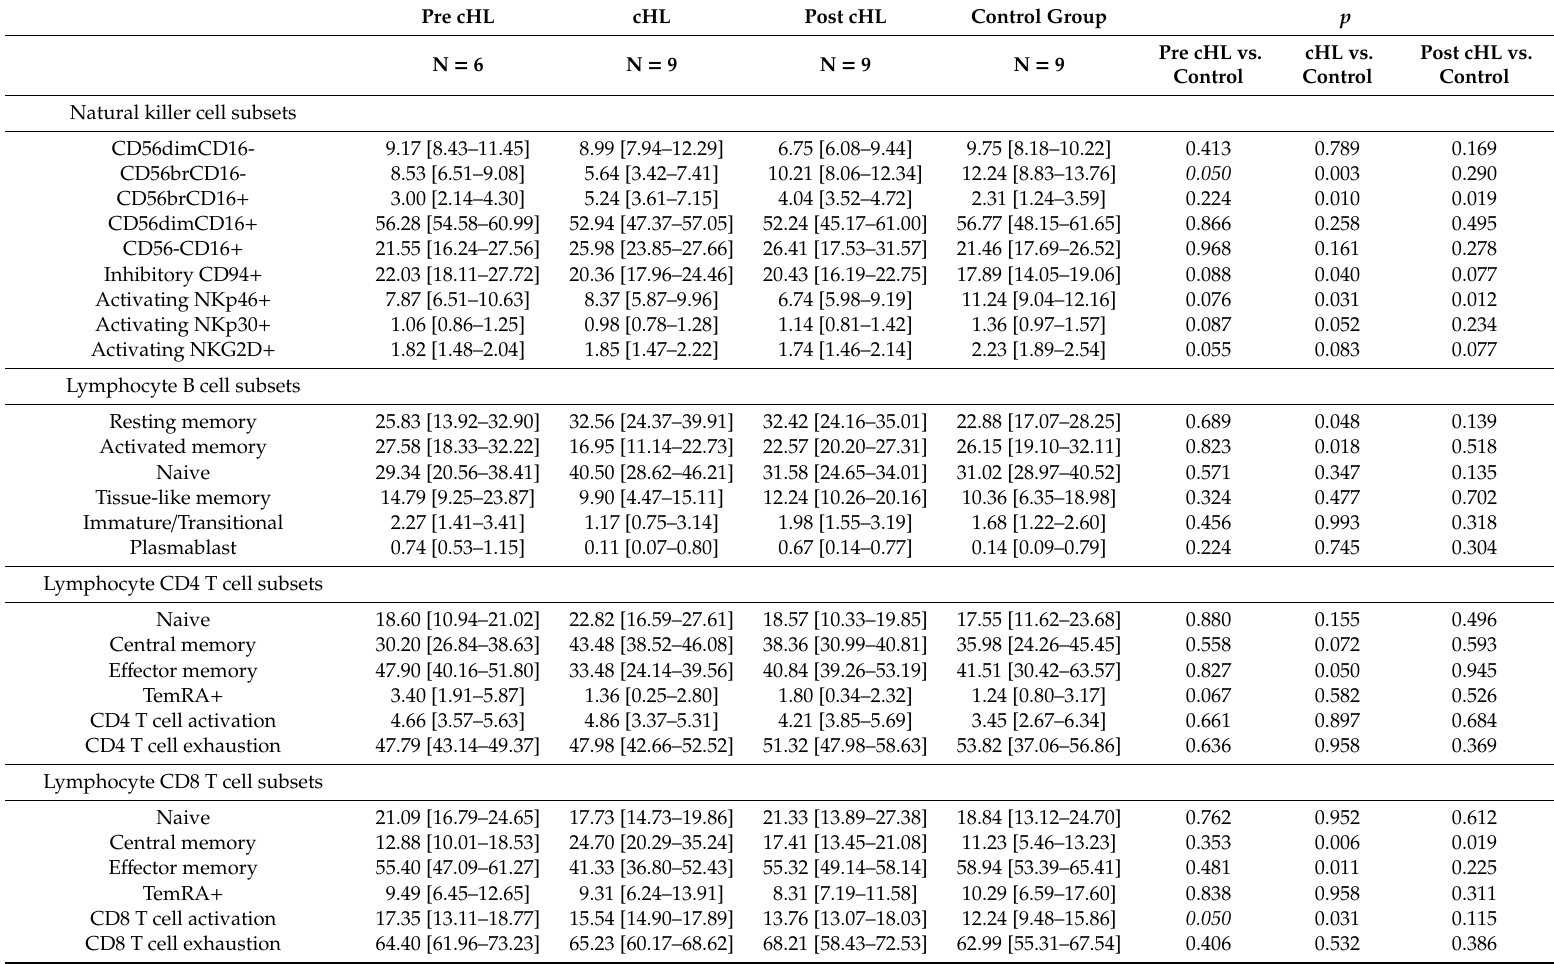
Table 3. Cell phenotype in individuals with cHL and